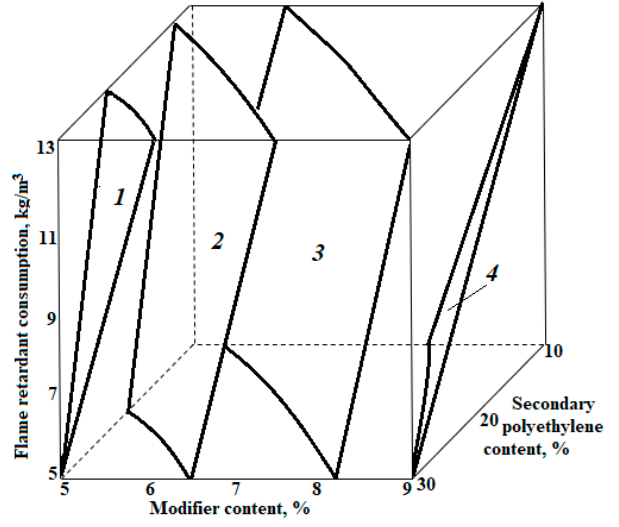
Figure 4. Dependence of the average density of polyethylene foam on variable factors: 1–32 kg/m 3 ; 2–28 kg/m 3 ; 3–24 kg/m 3 ; 4–20 kg/m 3 .